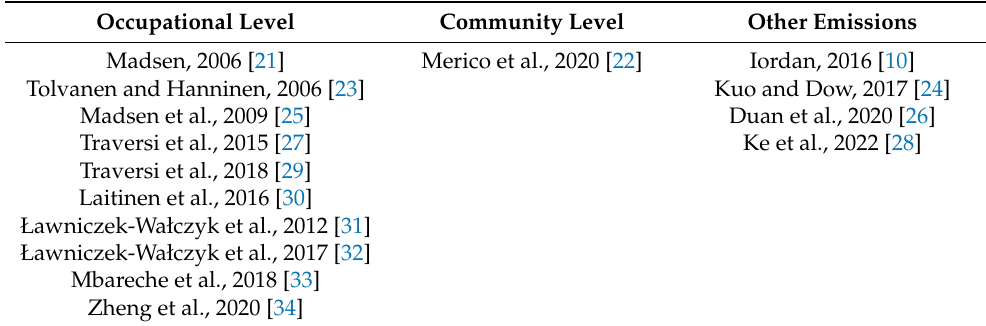
Table 4. List of included papers identified as environmental monitoring studies. The papers are listed